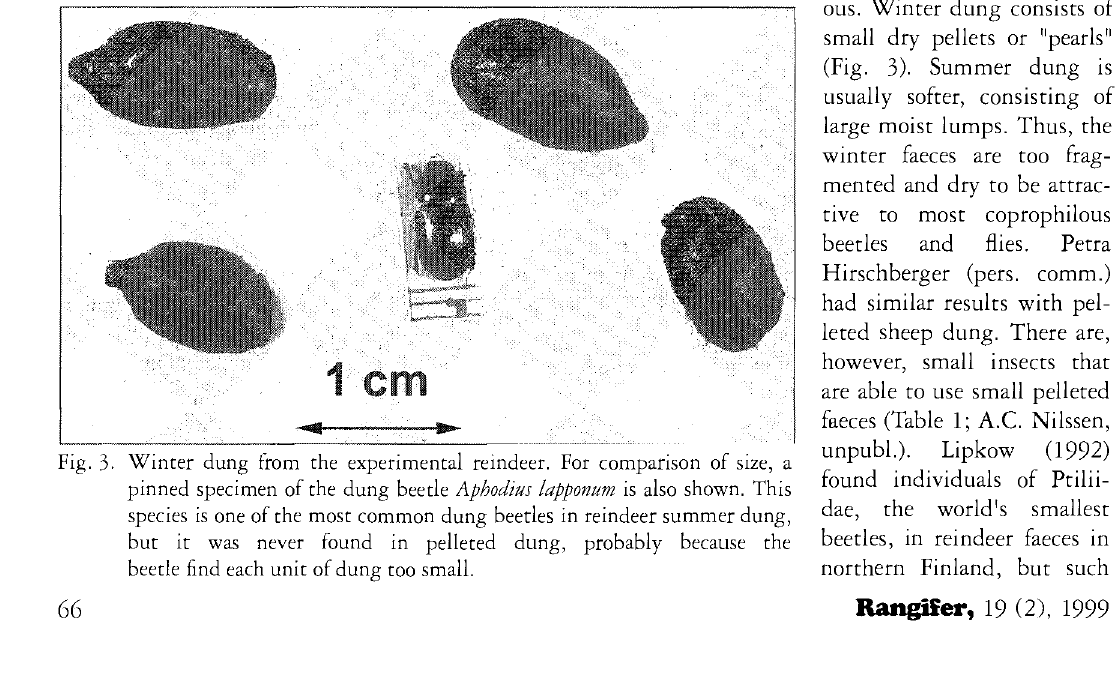
Fig. 3. Winter dung from the experimental reindeer. For comparison of size, a pinned specimen of the dung beetle Aphodim lapponum is also shown. This species is one of the most common dung beetles in reindeer summer dung, but it was never found in pelleted dung, probably because the beetle find each unit of dung too